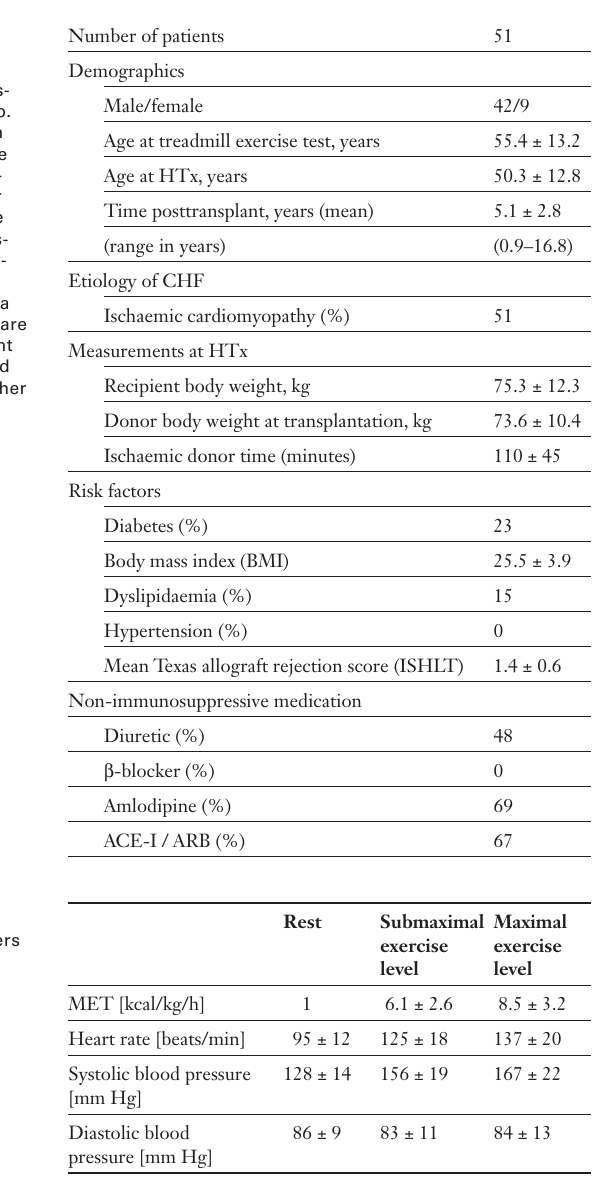
Demographic and clinical characteris- tics of study group. ACE-I: angiotensin converting enzyme inhibitor; ARB: an- giotensin receptor type II blocker.The binary variables is- chaemic cardiomy- opathy, diabetes, BMI, dyslipidaemia and hypertension are provided in percent of patients affected or treated with either medication (%).